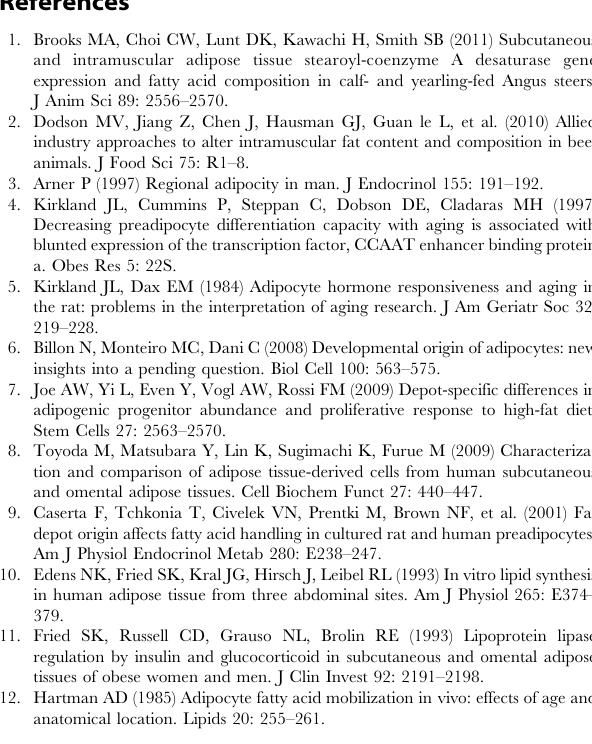
Figure S1 Data quality control using FastQC. Table S1 The primer sequence of DEG used for qRT-PCR analysis. Table S2 RNA-seq reads and mapping rate of different adipose depots from nine Hanwoo individuals. Table S3 Quantitative RT-PCR validation of DEGs in each adipose tissue.